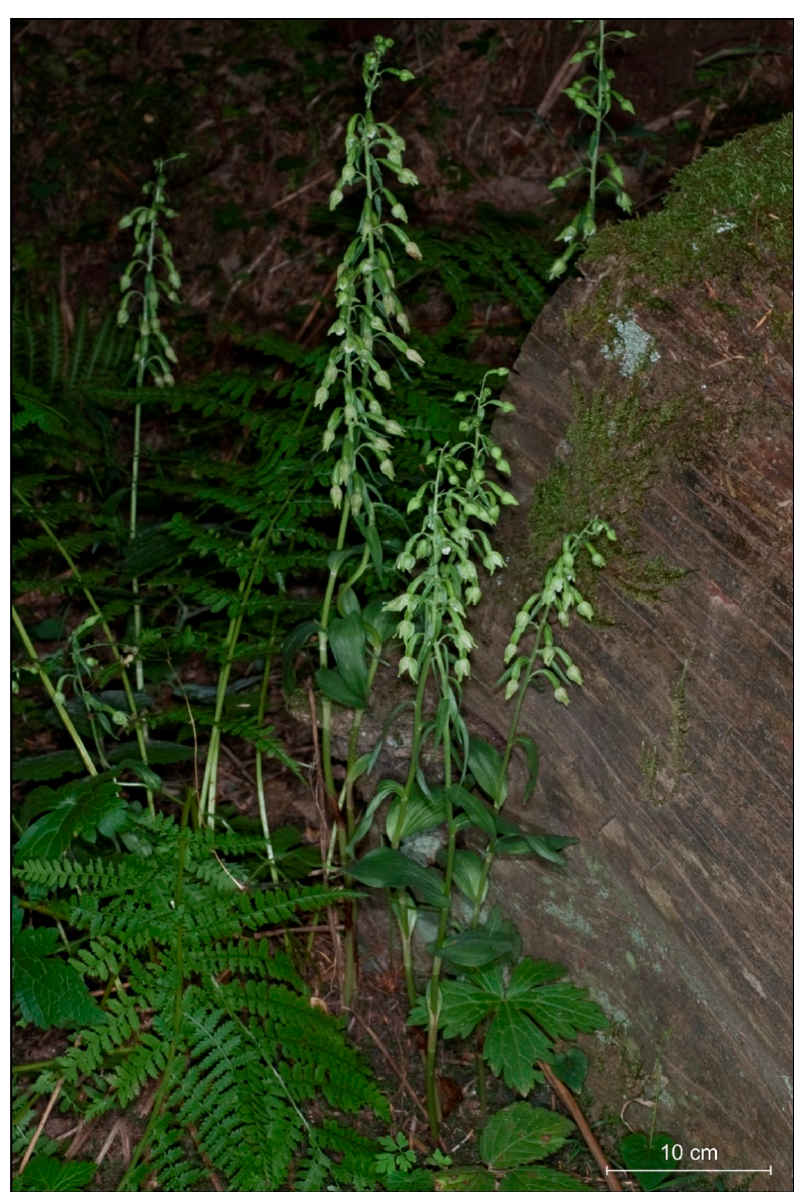
Figure 2. Natural population of Epipactis greuteri from Pertouli, Trikala in Greece, close to the locus classicus .